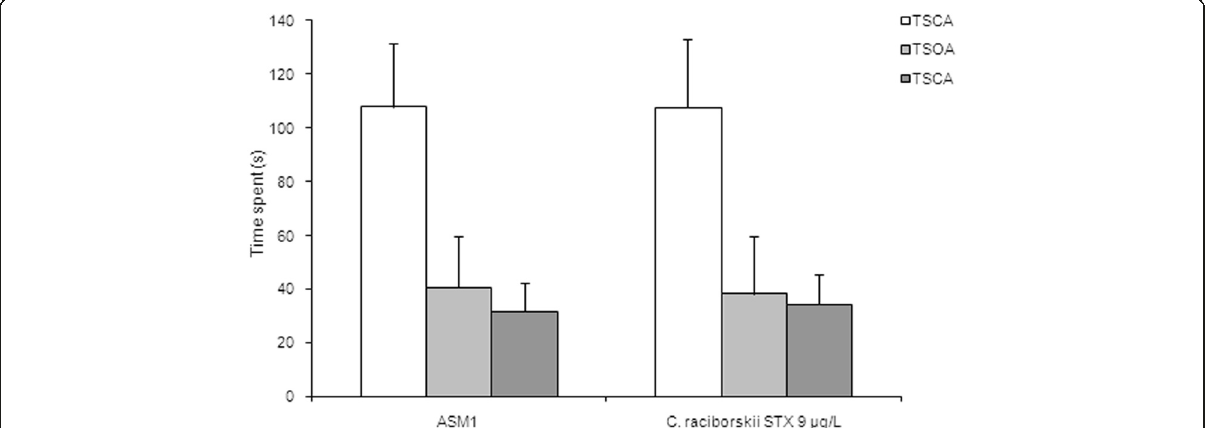
Fig. 3 Absence of effect of PST-producing C. raciborskii (9 μ g/L STX equivalents) in the EPM task. Data expressed as mean ± SEM; n = 10 per group; TSCA: time spent at closed arms; TSOA: time spent at open arms; TSCA: time spent at central